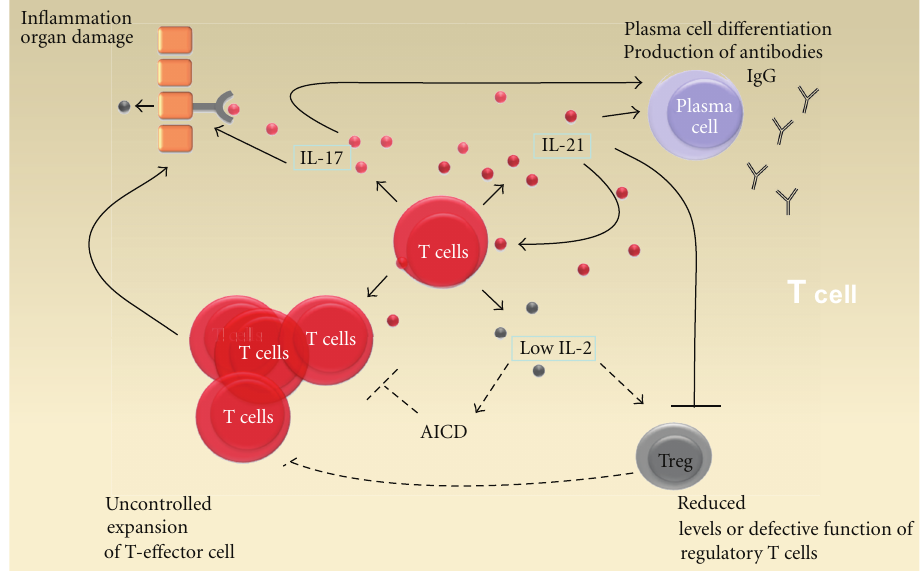
Figure 3: Dysregulated cytokine expression by T cells contributes to pathogenesis of SLE. SLE T cells secrete enhanced levels of IL-17 and IL-21 compared to healthy persons. IL-17 induces secretion of chemokines and other proinflammatory cytokines and therefore participates in tissue inflammation and organ damage. IL-21 and IL-17 both promote di ff erentiation of B cells into plasma cells and production of IgG antibodies. IL-21 further maintains and expands occurrence of Th17 cells. In contrast SLE T cells have a defective production of IL-2, which leads to reduced level of regulatory T cells and defective function of T cells, which might also be caused by IL-21. Since IL-2 is crucial for AICD, low levels of IL-2 might be responsible for reduced AICD leading to expansion of autoreactive T cells, which further trigger B-cell activation and tissue